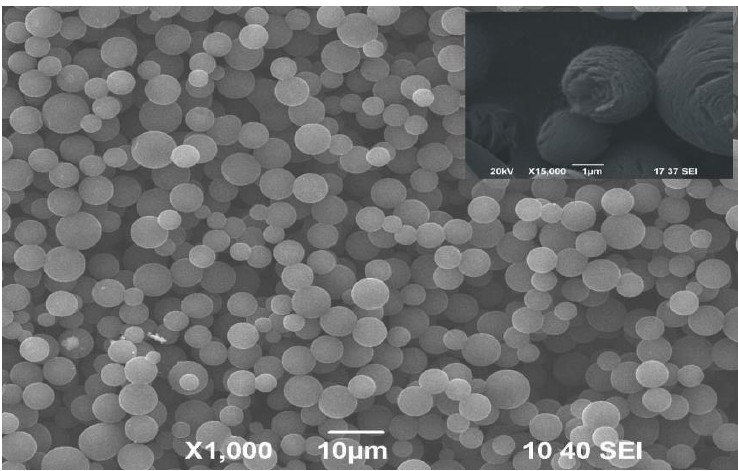
Figure 1. SEM images of carbon spheres before and after (inset) their graphitization.